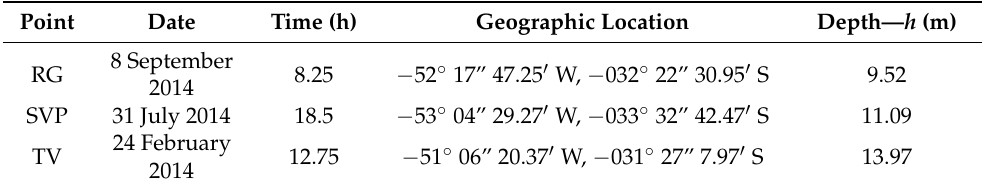
Table 2. Characteristics of each point selected for the